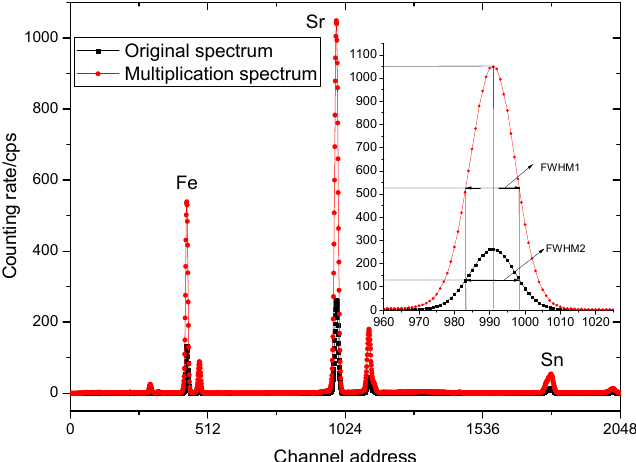
Figure 6. Comparison of the spectra before and after using the pulse circulation method. Table 1. Comparison of counting rates before and after multiplication. (Only the pulse circulation method is used) .